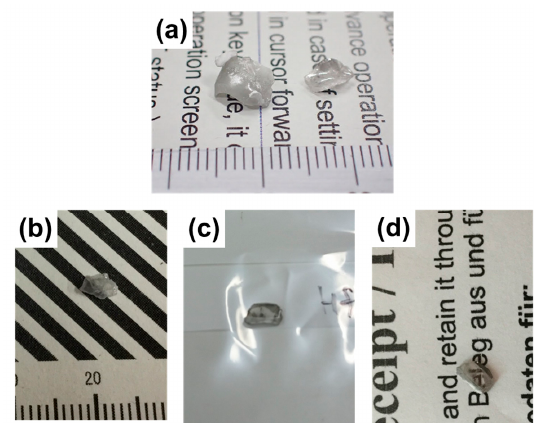
Figure 3. Photographs of ( a ) as-grown Yb1%:Lu 2 O 3 , ( b ) Yb1%:Lu 2 O 3 , ( c ) Yb1%:Lu 0.388 Hf 0.612 O 1.806 , and ( d ) Yb1%:Lu 0.18 Hf 0.82 O 1.91 after cutting and polishing.